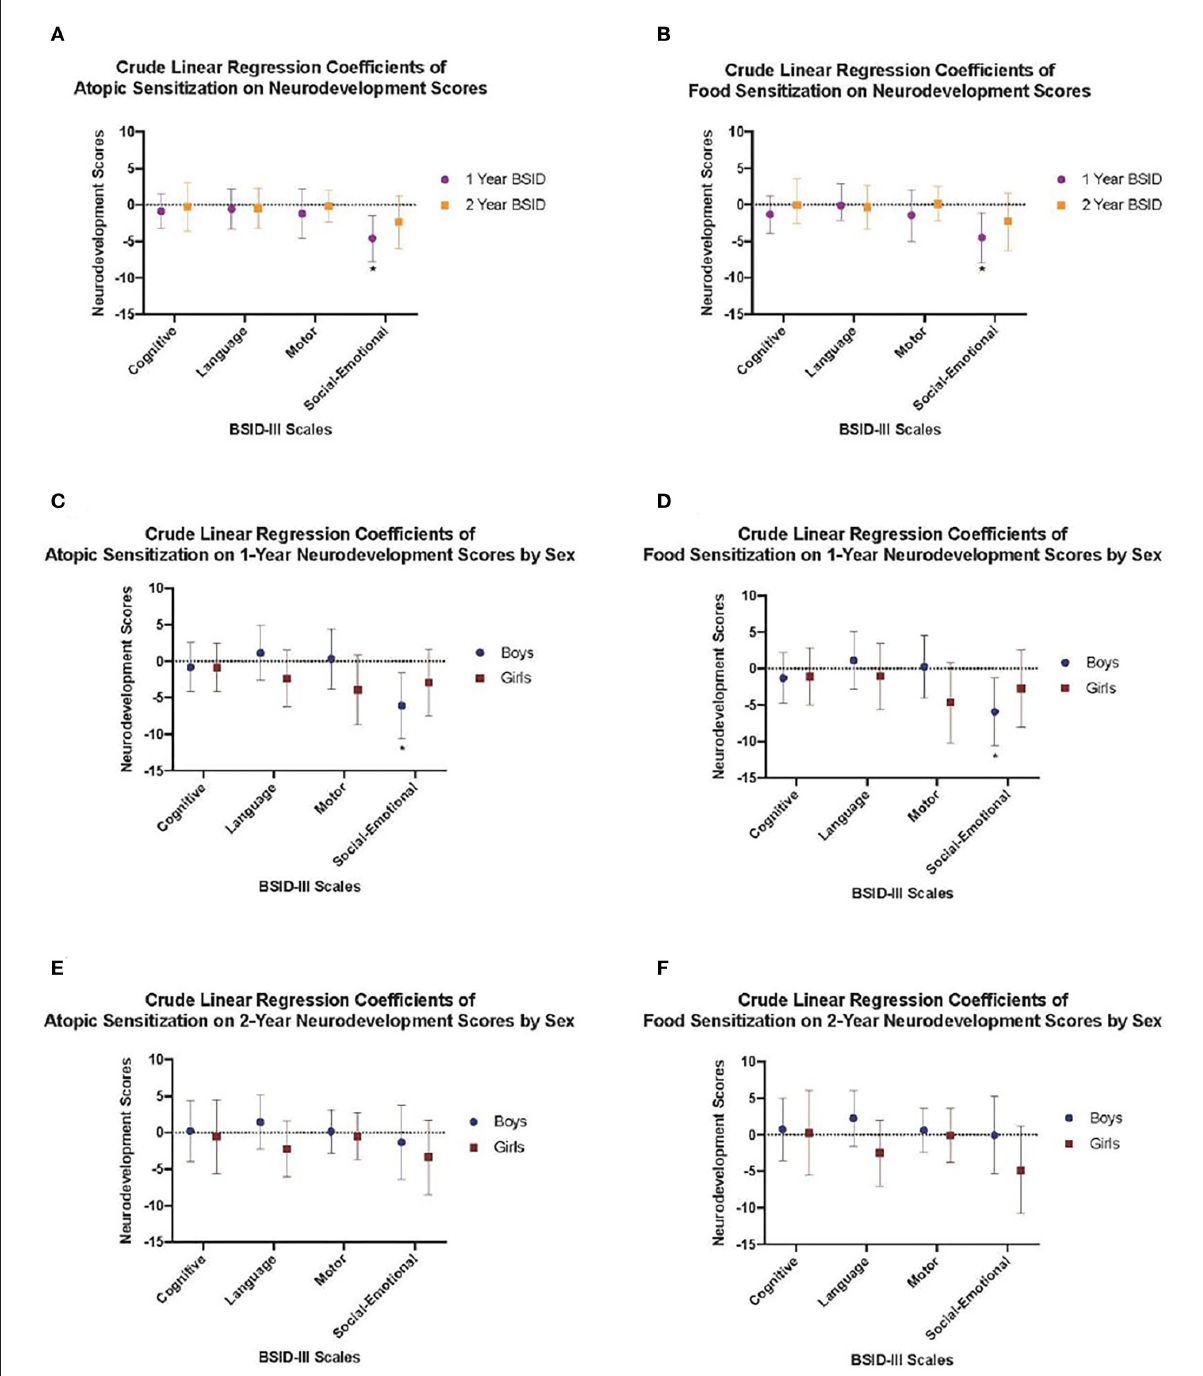
FIGURE2 Crude linear regression models demonstrating (A) Crude models of atopic sensitization at 1 year on neurodevelopement scores at 1 and 2 years, (B) Food sensitization at 1 year on neurodevelopement scores at 1 and 2 years, (C) Atopic sensitization at 1 year on neurodevelopement scores at 1 year stratified by child sex, (D) Food sensitization at 1 year on neurodevelopement scores at 1 year stratified by child sex, (E) Atopic sensitization at 1 year on neurodevelopement scores at years stratified by child sex, and (F) Food sensitization at 1 year on neurodevelopement scores at 2 years stratified by child sex. Crude regression coefficient estimates are shown by closed circles and whiskers represent the 95% confidence